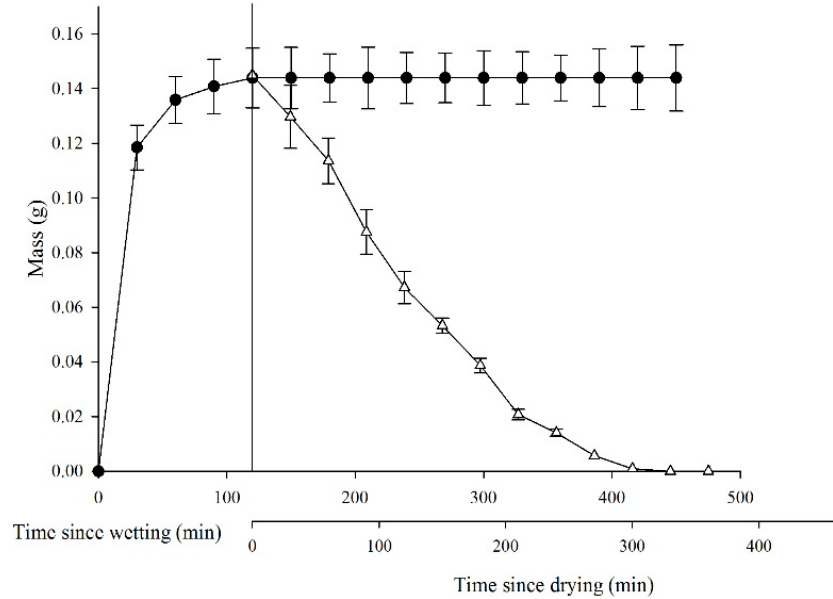
Figure 1. Dynamics of water absorption and dehydration in Lepidium apetalum seeds. • represents water absorption of mucilaginous seeds; ∆ represents dehydration of mucilaginous seeds. Values represent mean ± SE.